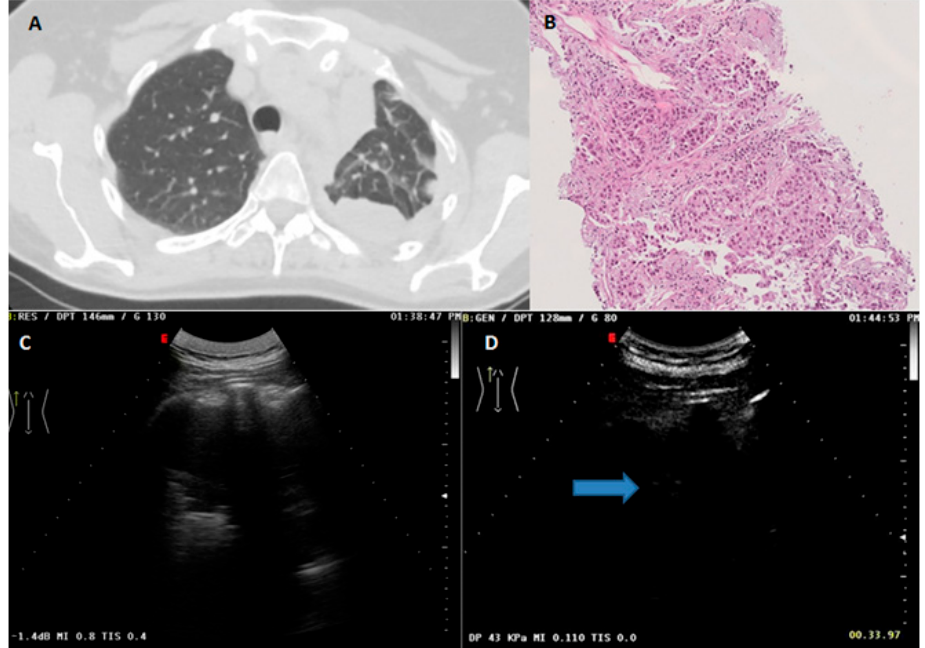
Figure 3. ( A ) Axial chest CT scan (lung window) showing a subpleural pulmonary lesion of the upper lobe extending in the superior segment of the lower lobe in the left lung. ( B ) Histopatholog-